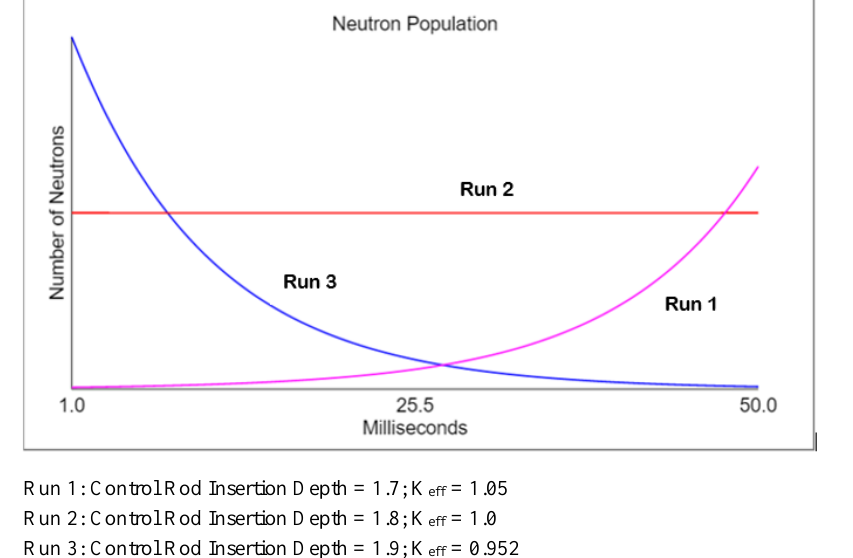
Fig. 29. Results of nuclear reactor dynamic